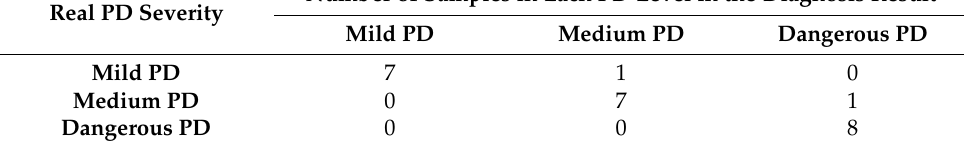
Table 6. Confusion matrix of the diagnosis result based on the back propagation neural network (BPNN).